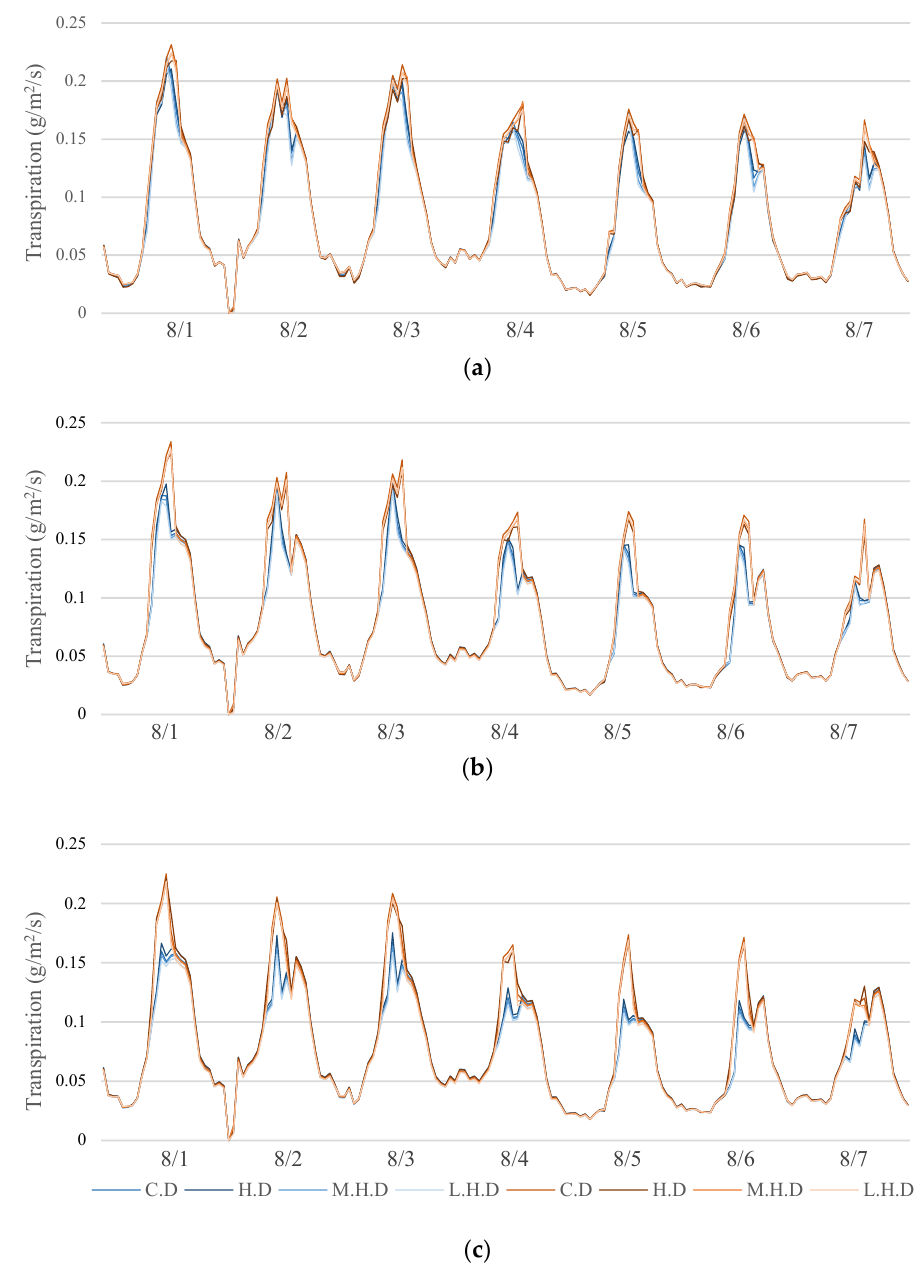
Figure 9. Change in transpiration rate with LAD distribution and tree location (blue lines are south trees and brown lines are north trees). ( a ) 1H, ( b ) 2H, ( c ) 3H.